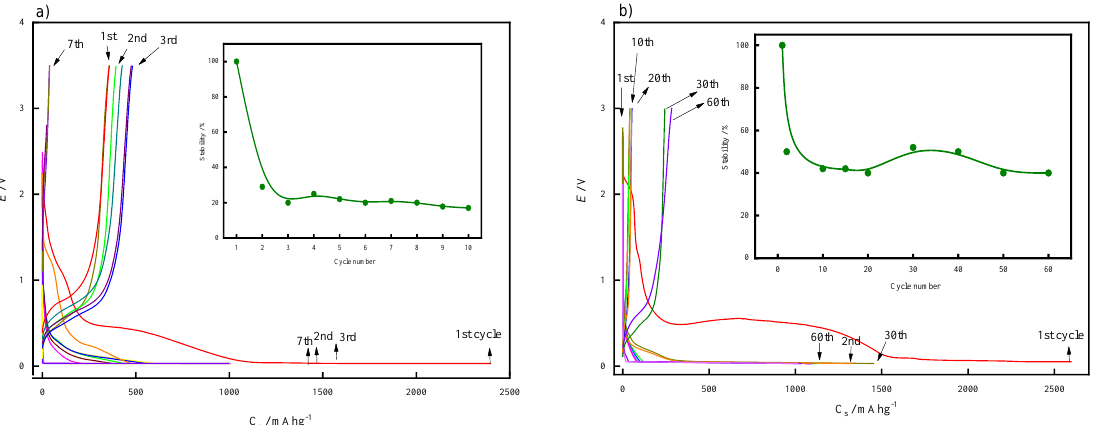
Figure 5. Galvanostatic charge / discharge at constant current 300 µA for: ( a ) HCSi20 electrode. Stability over 10 cycles (inset), ( b ) HCSi20 with FEC electrode. Stability over 60 cycles (inset).